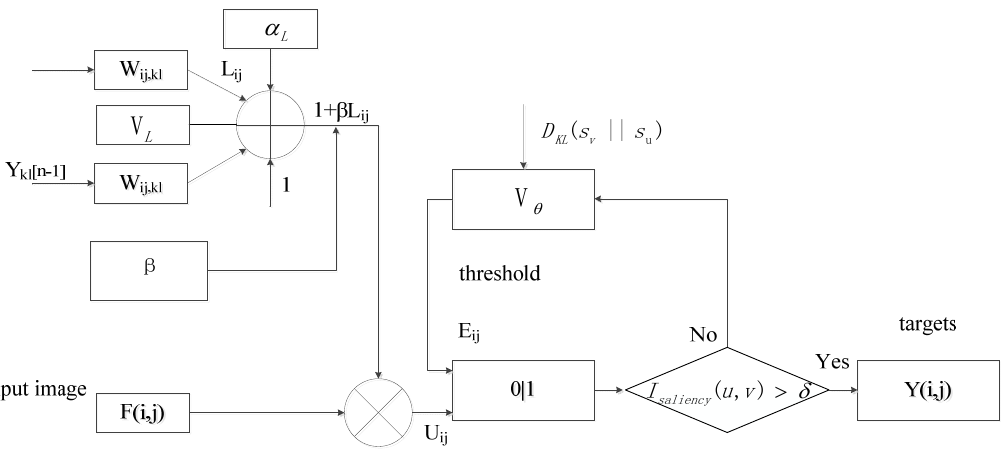
Figure 1. PCNN model structure guided by saliency mechanism.